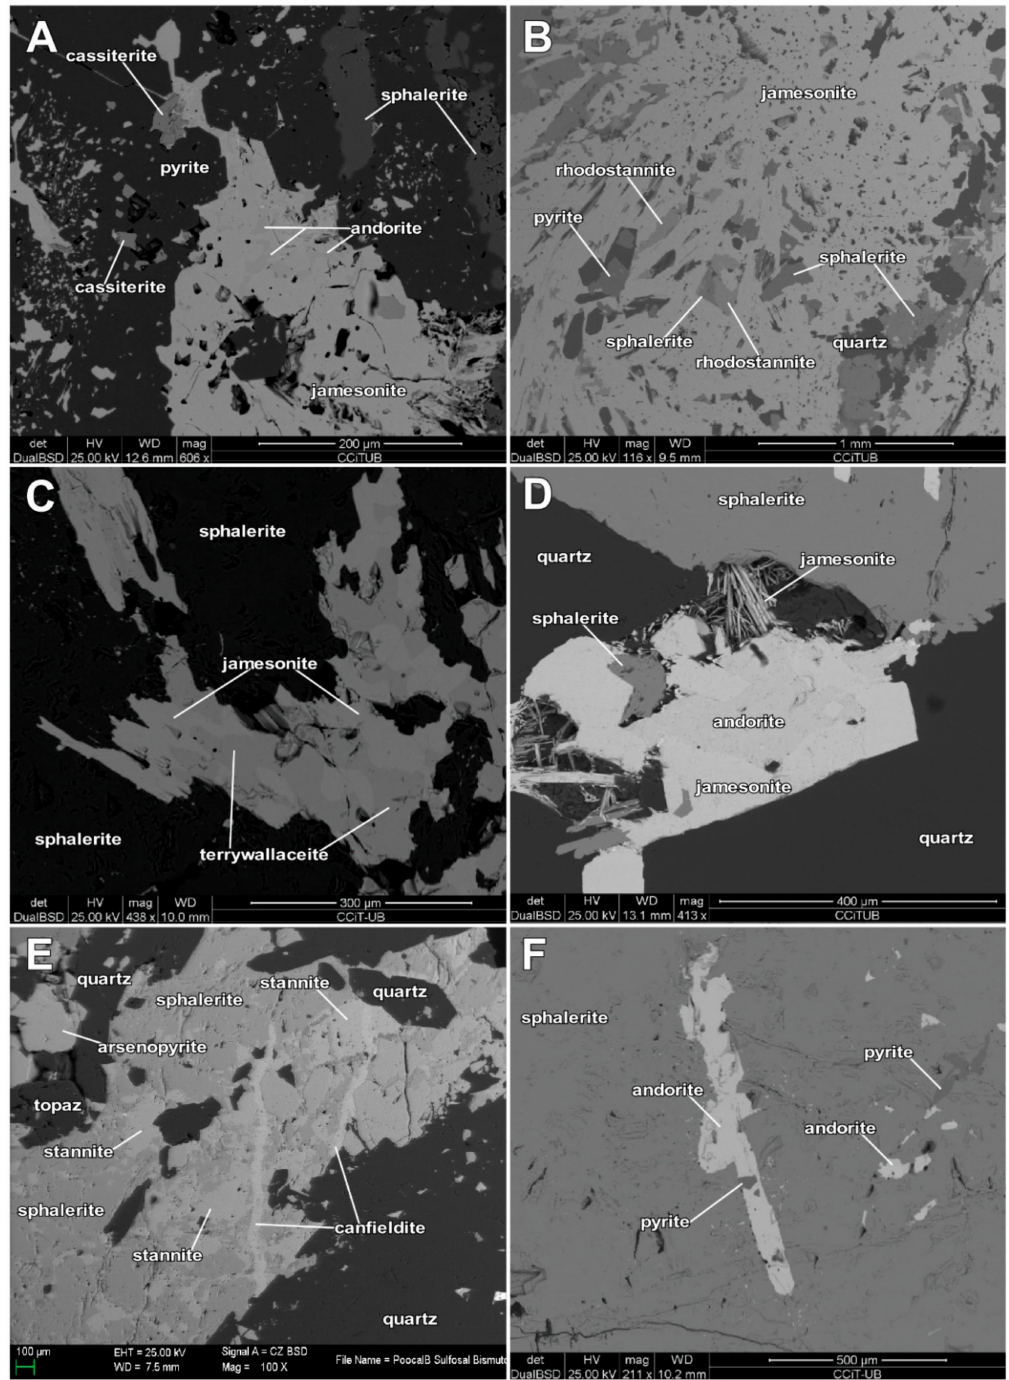
Figure 8. Back-scattered electron images of ore associations that are rich in lead and silver sulphosalts at the Poop ó deposit. ( A to C ) Earlier sphalerite, pyrite and cassiterite associations postdated by jamesonite with later andorite ( A ), rhodostannite ( B ) or intergrown with terrywallaceite ( C ). ( D ) Acicular jamesonite crystals with later andorite lining the remaining cavity. ( E ) Close topaz + arsenopyrite association (similar to Figure 5A) followed by a close sphalerite + stannite association, and by canfieldite-lined micro-fractures; sample from the Calaveras section. ( F ) Andorite + pyrite that reactively followed